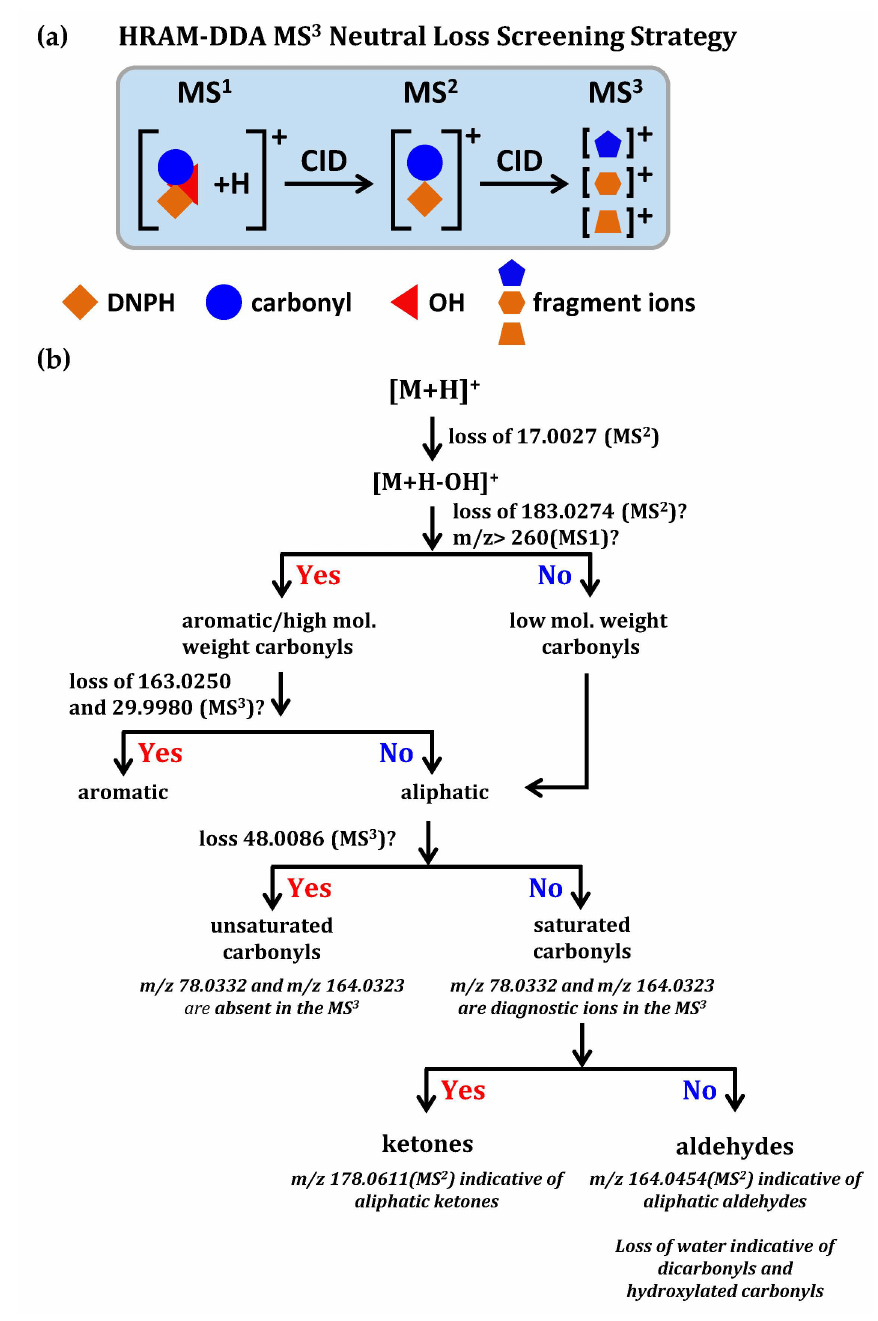
Figure 7. ( a ) Scheme of HRAM-DDA MS 3 neutral loss screening strategy; ( b ) classification scheme for characterizing known and unknown DNPH-derivatized carbonyls. Adapted with permission from [135]. Copyright 2017 American Chemical